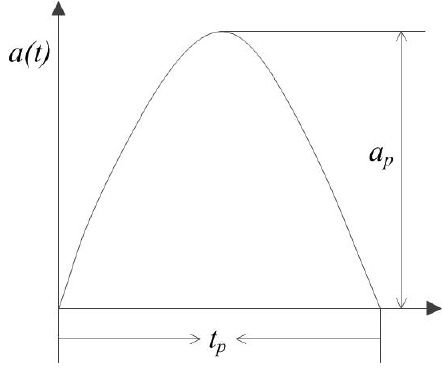
Figure 4. The half sine wave acceleration.